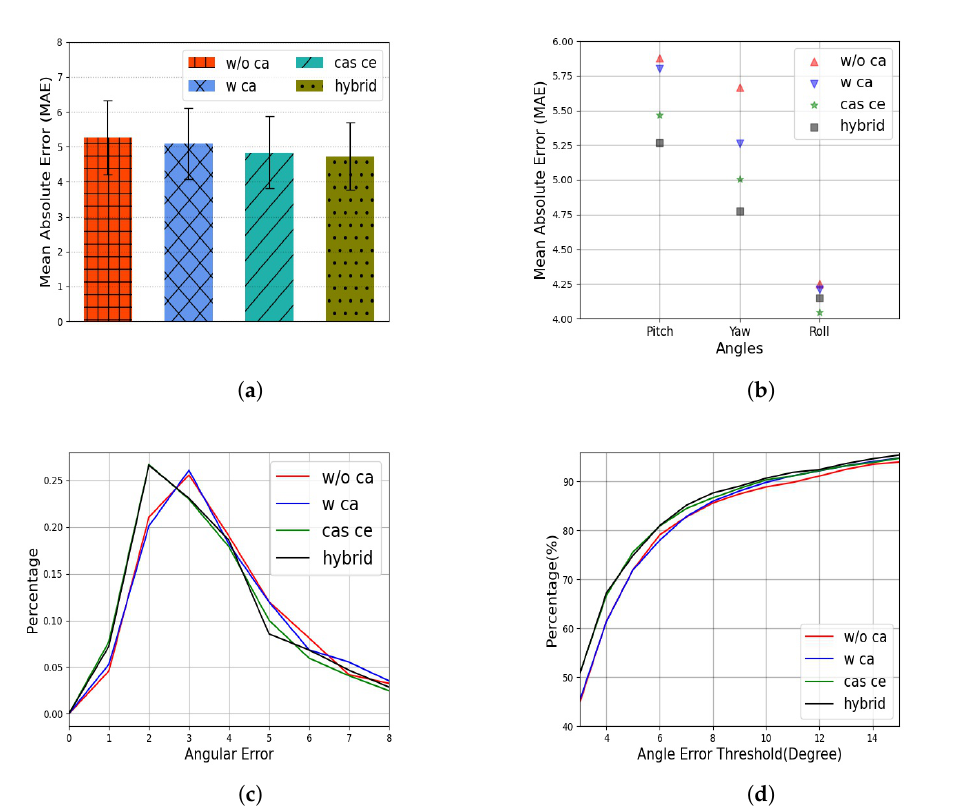
Figure 5. ( a ) The mean absolute error of the different paradigms on the AFLW2000 dataset; ( b ) the mean absolute error of the different paradigms on the different axes; ( c ) the percentage of different errors using the different paradigms; ( d ) the percentages of correct samples of the different paradigms under different